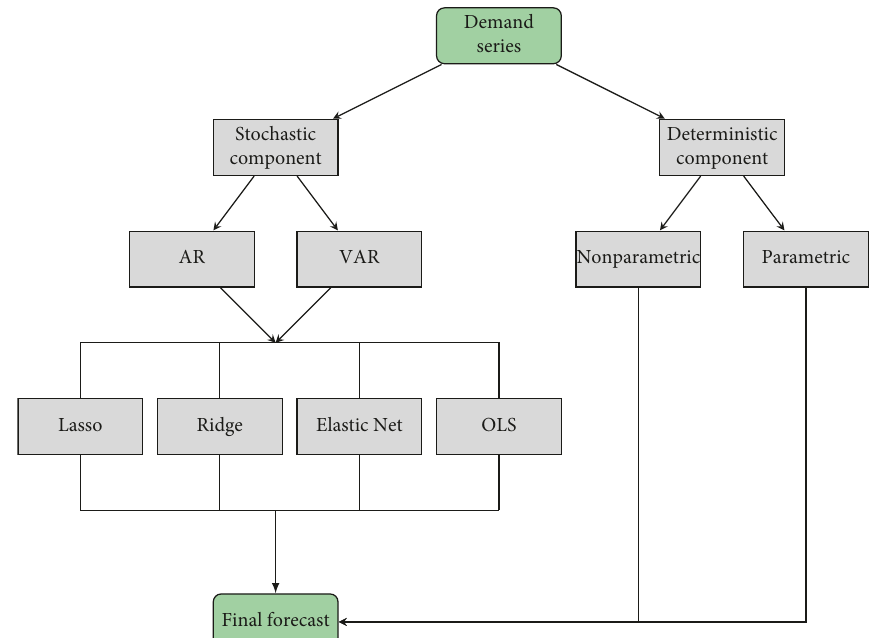
Figure 2: Flowchart of the proposed modeling framework.